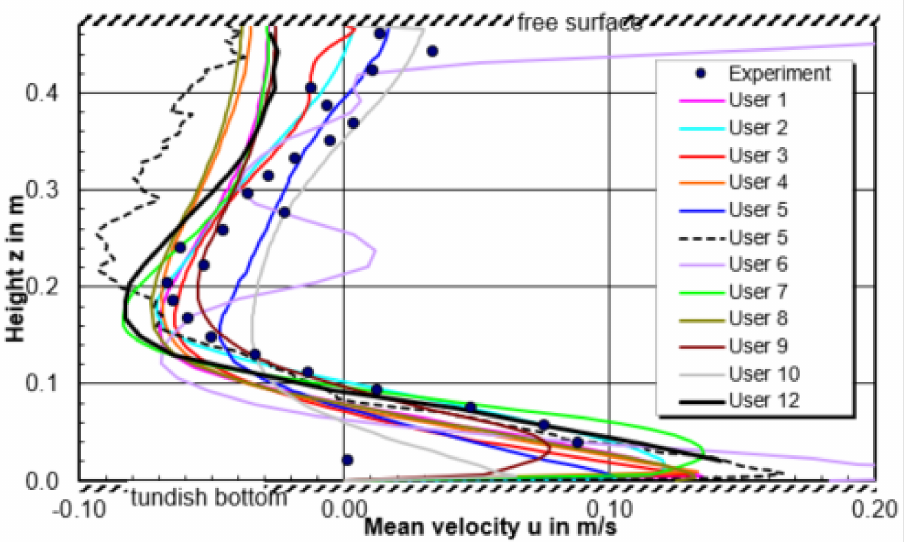
Figure 15. Comparison of horizontal u velocity in a vertical section through the center of the circulation region between users and